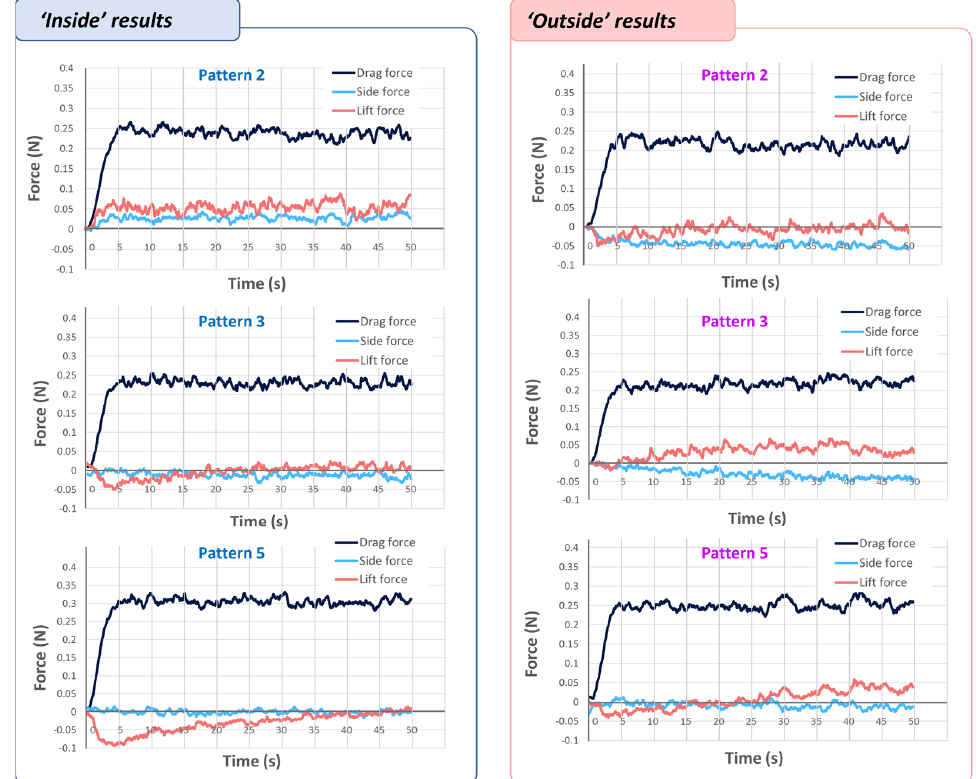
Figure 7. Measurements of the aerodynamic forces with different kirigami-patterned origami structures.